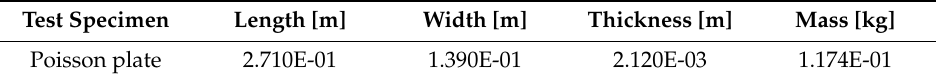
Table 3. Size and mass of the carbon / epoxy Poisson plate.